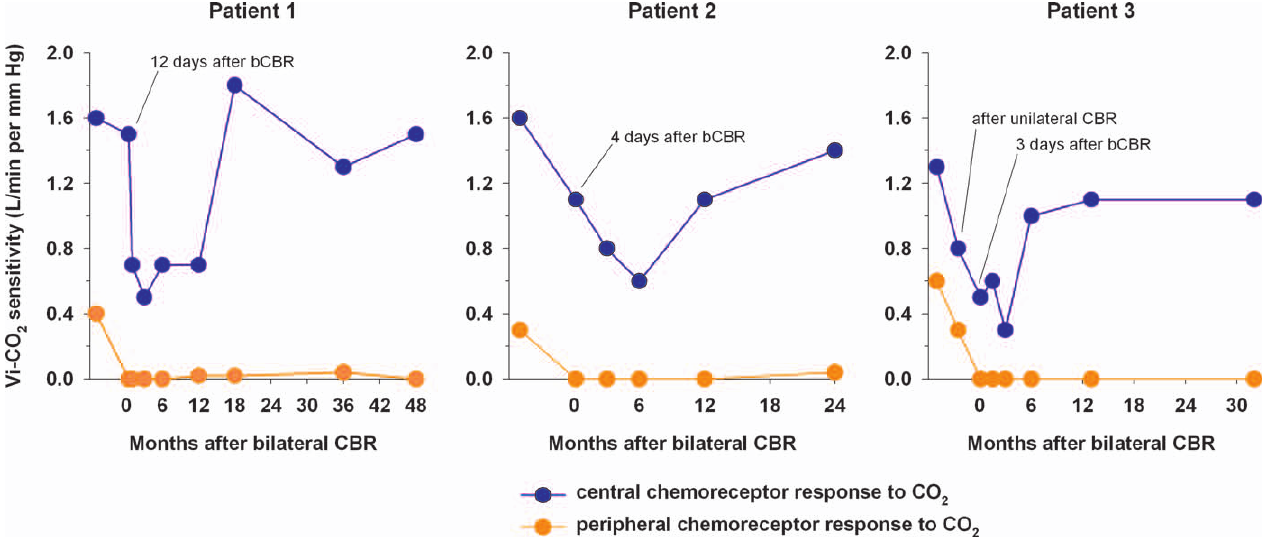
Figure 6. Central and Peripheral Chemoreceptor Activity in Response to Stimulation with CO 2 in the Three Patients during the Whole Testing Period In all three patients bCBR caused the loss of the peripheral component or reduction to a value of less than 10% of preoperative values combined with an initial sharp reduction in the magnitude of the central component to about 30% of preoperative values, which was followed by a slow increase to values 85%–95% of the preoperative values. In patient 3 we also obtained data after unilateral carotid body resection. doi:10.1371/journal.pmed.0040239.g006 PLoS Medicine |